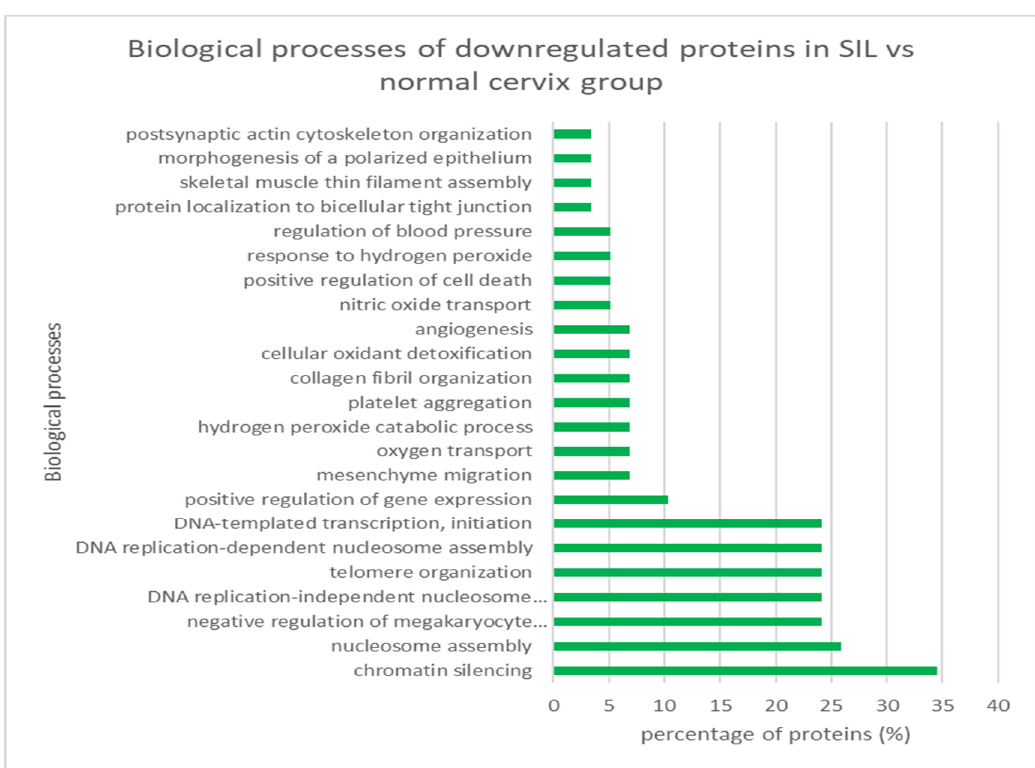
Figure 2. Classification of biological processes of downregulated proteins in SIL vs. normal cervix group. The percentage reflects the number of proteins involved. The gene ontology classifications were generated using DAVID version 6.8 (released 19 February 2022). Protein–protein interaction network analysis was performed with STRING. Table 2. Pathways involved in downregulated proteins in SIL vs. Normal cervix group using ConsensusPathDB software.